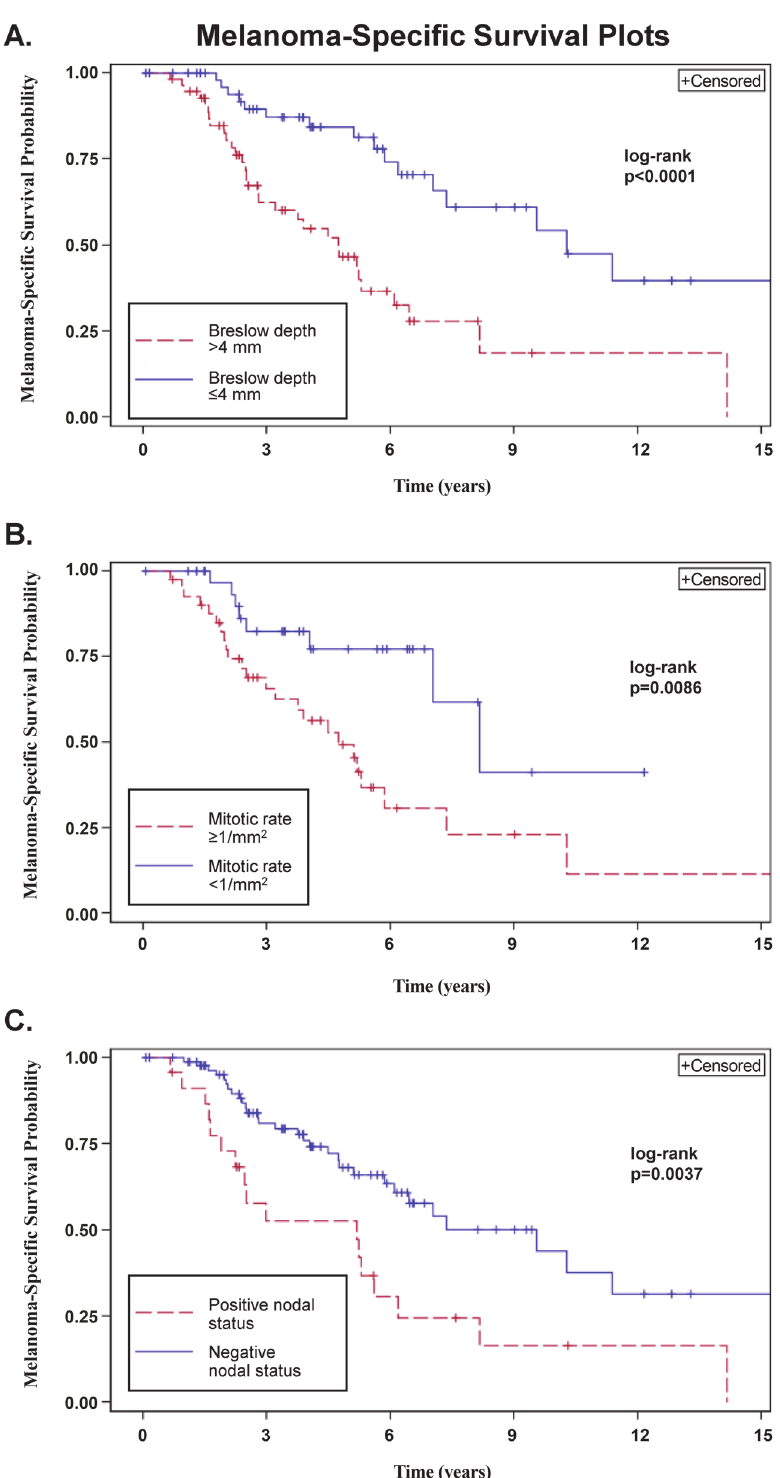
Fig 3. Impact of clinicopathologic factors on melanoma-specific survival (MSS) in patients with clinically localized desmoplastic melanoma. A. MSS by Breslow thickness ( (cid:3) 4 mm vs. > 4 mm). B. MSS by mitotic rate ( (cid:1) 1/mm 2 vs. < 1/mm 2 ). C. MSS by nodal